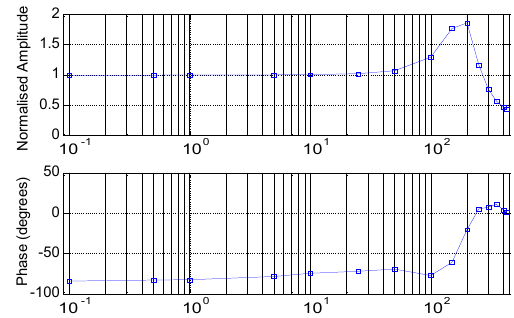
Fig. 14. Amplitude and phase frequency response of the